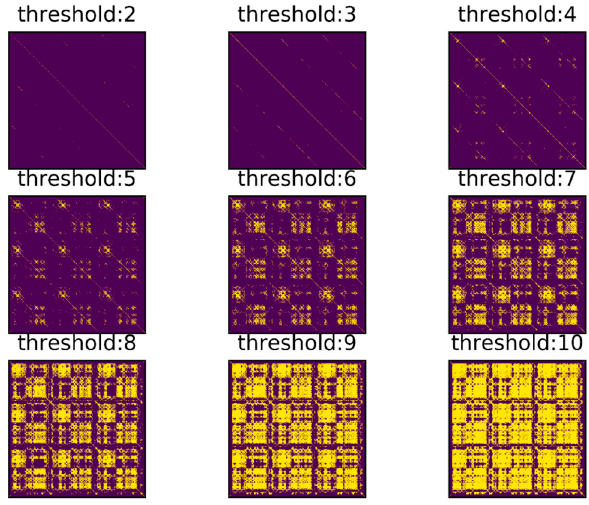
Figure 5. Images of selected points under different threshold.